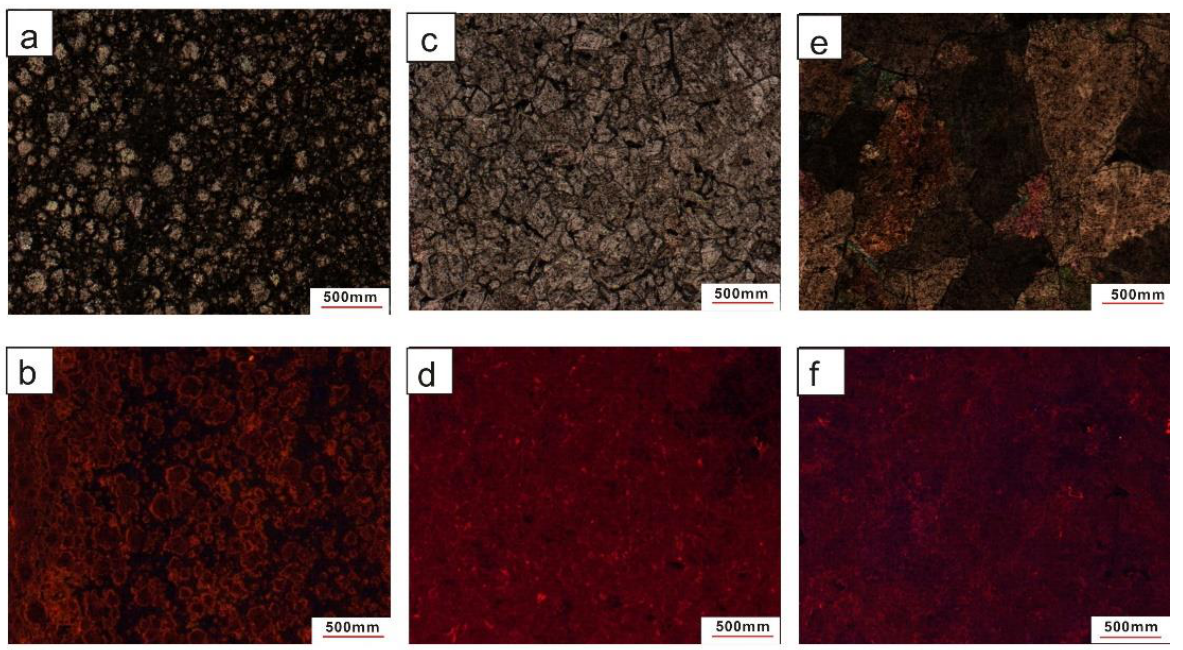
Figure 3. Photographs showing general petrographic features of GWS dolomites in Sichuan basin: ( a ) Microcrystalline dolomite, dolomite crystals showed the dull-red to zero-luminescence at the centers and the bright-red at the thin rims; ( b ) CL of Microcrystalline dolomite; ( c ) Fine crystalline dolomite; ( d ) CL of Fine crystalline dolomite; ( e ) Medium crystalline dolomite; ( f ) CL of Medium crystalline dolomite, the crystals exhibited mottled dull-red luminescence.